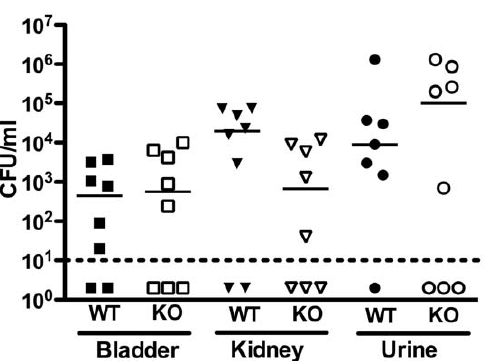
Figure 1. GBS b H/C is important for induction of cytokine mRNA in human bladder epithelial cells. Monolayers of 5637 cells were exposed to medium alone, WT, D cylE , or complemented GBS strains for 1 h. Transcript levels for different proinflammatory cytokines were determined using qRT-PCR with normalization to GAPDH. RQ values were calculated by comparative CT ( DD CT), and fold difference over transcript levels in bacteria exposed to medium alone was determined. RQ fold difference values from triplicate readings in